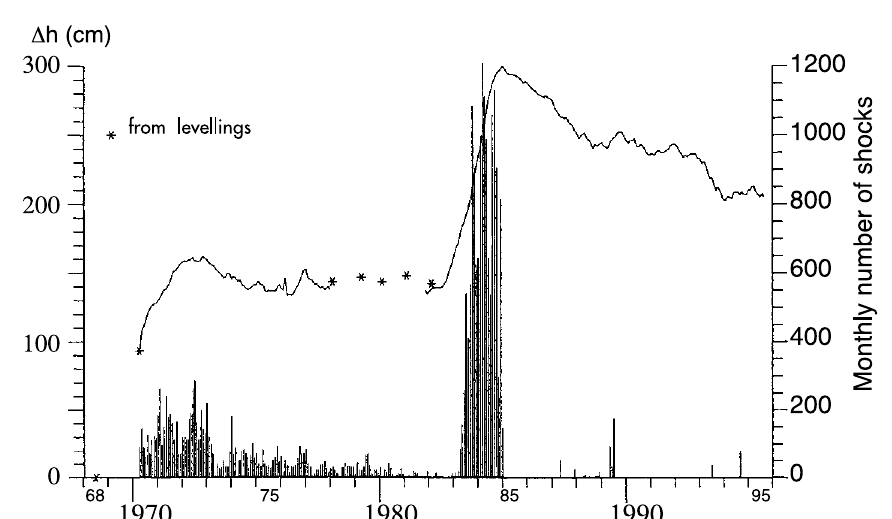
Fig. 3. Seismicity (monthly numbers of shocks) and uplifts (cm) at Pozzuoli during the period 1970~1995 (after Berrino, 1998).